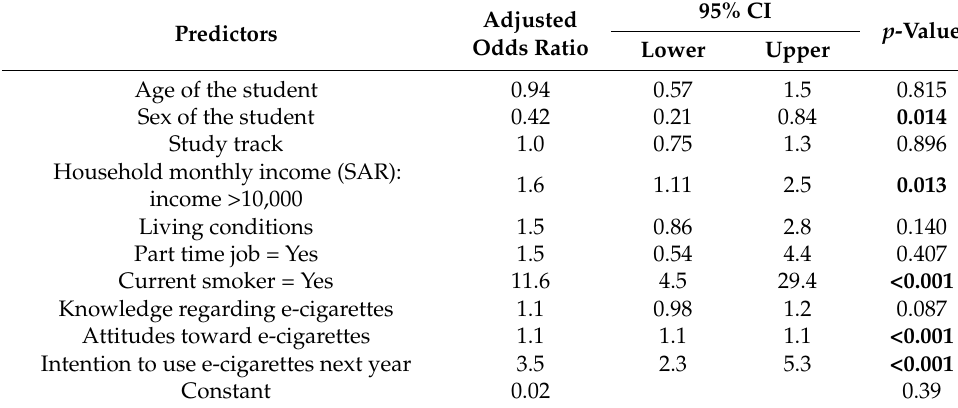
Table 6. Predictors of e-cigarette use by multivariate logistic regression